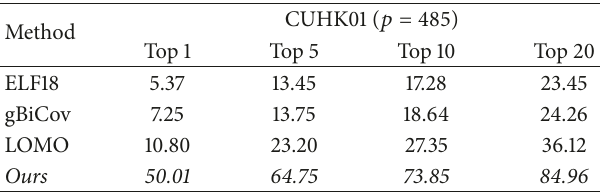
Table 3: Comparison of state-of-the-art results of feature represen- tation reported with CUHK01 database. The cumulative matching scores (%) at ranks 1, 5, 10, and 20 are listed.